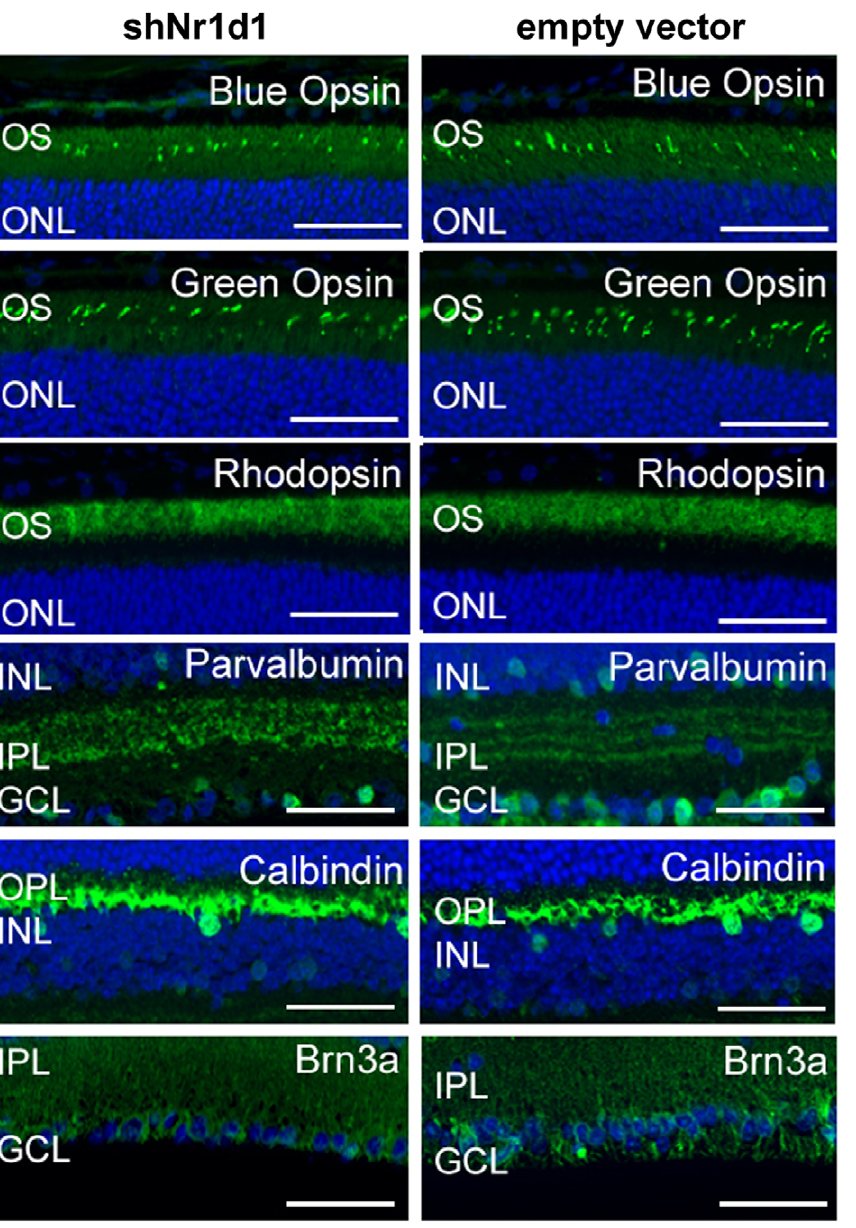
Figure 5. Cell type specific markers do not reveal abnormalities in retinal cell number or localization in shNr1d1 injected mice. Labeling with markers for Blue opsin (blue (S-) opsin expressing cones), Green opsin (green (M-) opsin expressing cones), Rhodopsin (Rod cells), Parvalbumin (amacrine cells), Calbindin (horizontal cells), and Brn3a (ganglion cells) did not reveal any problems with cell placement, organization or morphology within the retina when examined at postnatal day 30.5. n=3. Scale bar =50 m